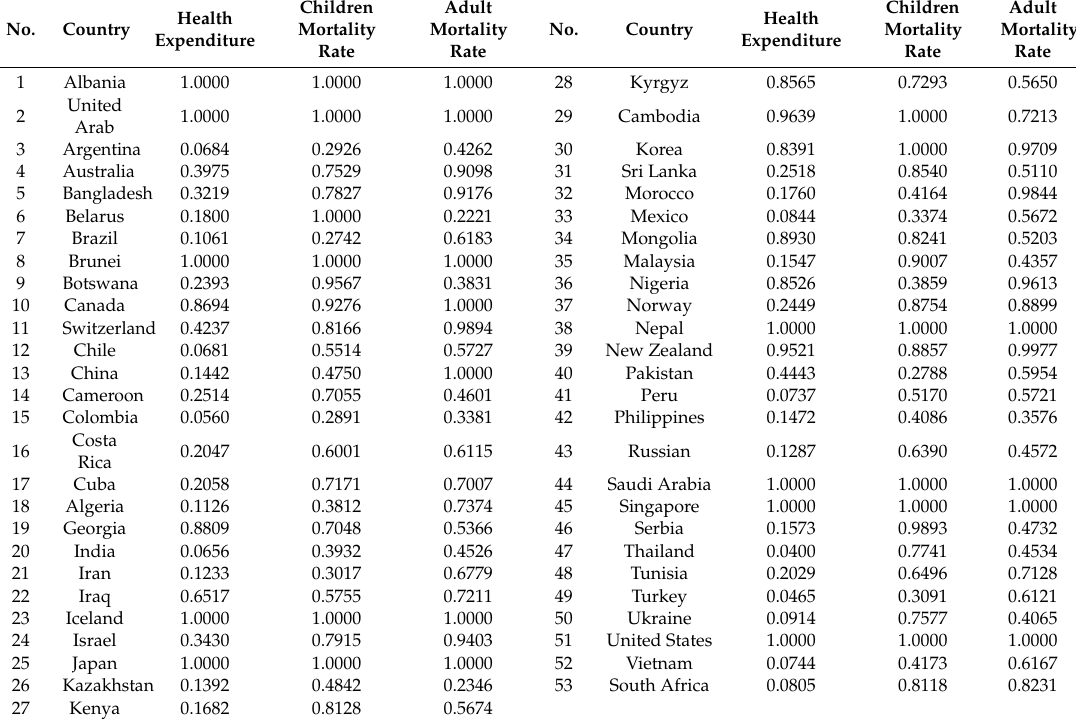
Table 12. Comparison of the annual health e ffi ciencies of non-EU countries from 2010 to 2014. No.